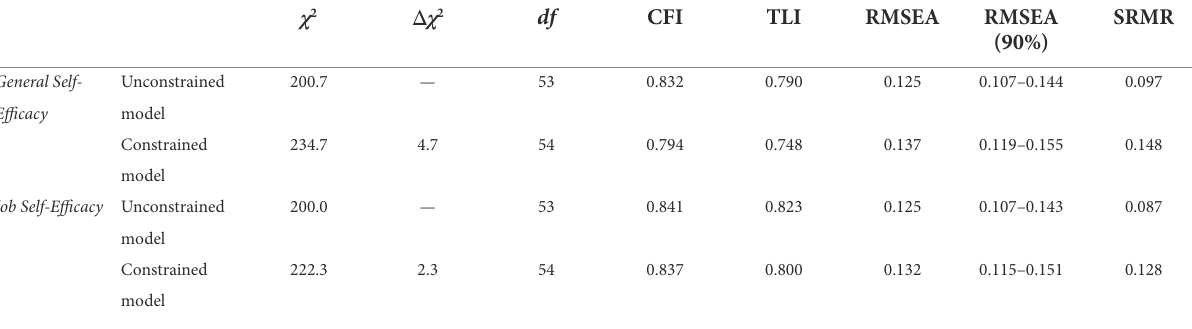
TABLE 4 The goodness of fit statistics for tests of Self-Efficacy and professional